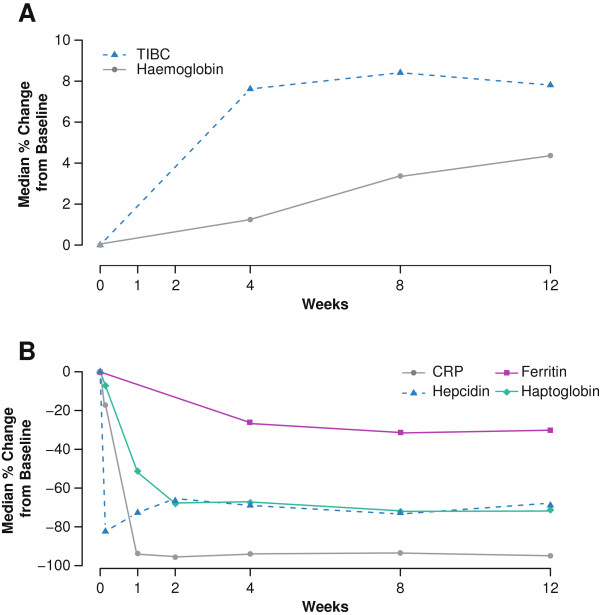
Time course of median percentage change in (A) haematological and (B) inflammatory markers. Patients received tocilizumab + MTX. TIBC, total iron-binding capacity. MTX, methotrexate.